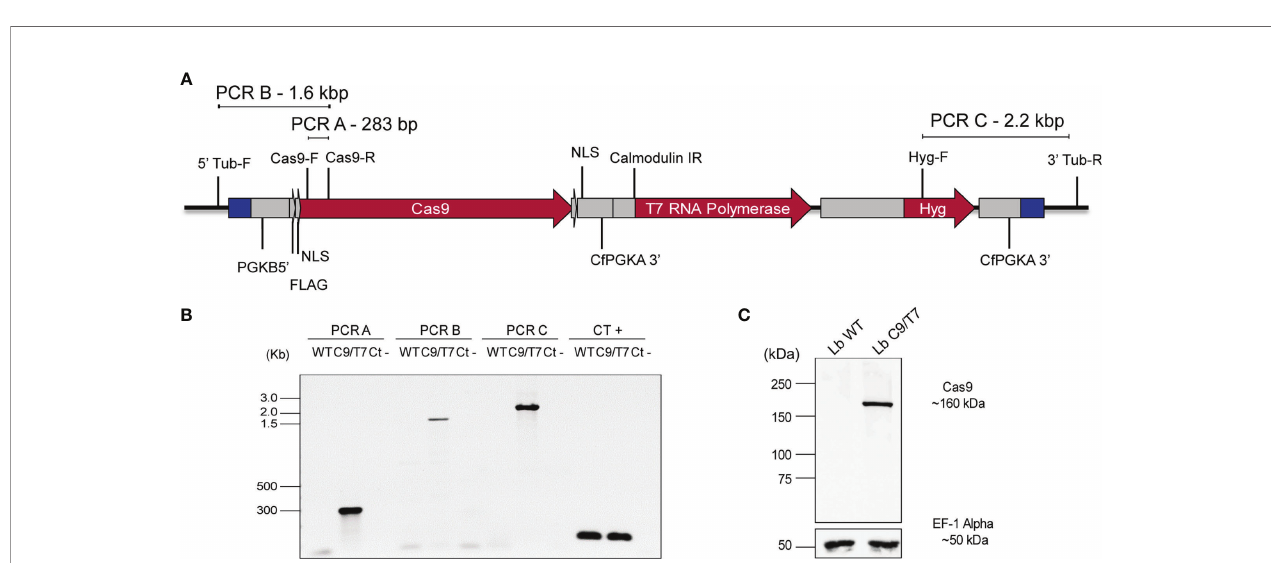
FIGURE 2 | Con fi rmation of pTB007_Viannia cassette integration and Cas9 expression in Leishmania braziliensis M2903 Cas9/T7 lineage (Lb C9/T7). (A) Schematic representation of pTB007_Viannia cassette after integration in b -tubulin locus on chromosome 33 (black line) and primers used in each PCR to con fi rm the integration and correct orientation of this cassette in the transfectants (Lb C9/T7). (B) The presence of Cas9 CDS in the transfected population was con fi rmed using the primer pair Cas9-F and Cas9-R (PCR-A) which ampli fi ed a 283-bp fragment in Lb C9/T7 but not in Lb WT cell line. The correct orientation of the cassette in the b -tubulin locus was con fi rmed using the primer pairs — 5 ′ Tub-F and Cas9-R (PCR-B) in the 5 ′ end and Hyg-F and 3 ′ Tub-R (PCR-C) in the 3 ′ end — and ampli fi ed fragments of 1.6 and 2.2 kb, respectively, only in the C9/T7 line. To con fi rm the presence of DNA in the reactions, a positive control PCR (CT +) was done using the primer pair tbp -F and tbp -R which anneals in the TATA box-binding protein CDS. (C) Expression of Cas9 in the transfectant line (Lb C9/T7) and in the WT (Lb WT) was assessed through Western blotting using an anti-FLAG antibody. The presence of a ~160-kDa band relative to the Cas9 protein fused to a FLAG tag was observed only in Lb C9/T7 con fi rming the expression of this protein in this cell line. The loading control was done using an anti-EF-1-Alpha antibody which revealed a ~50-kDa band in both Lb WT and Lb C9/T7 protein